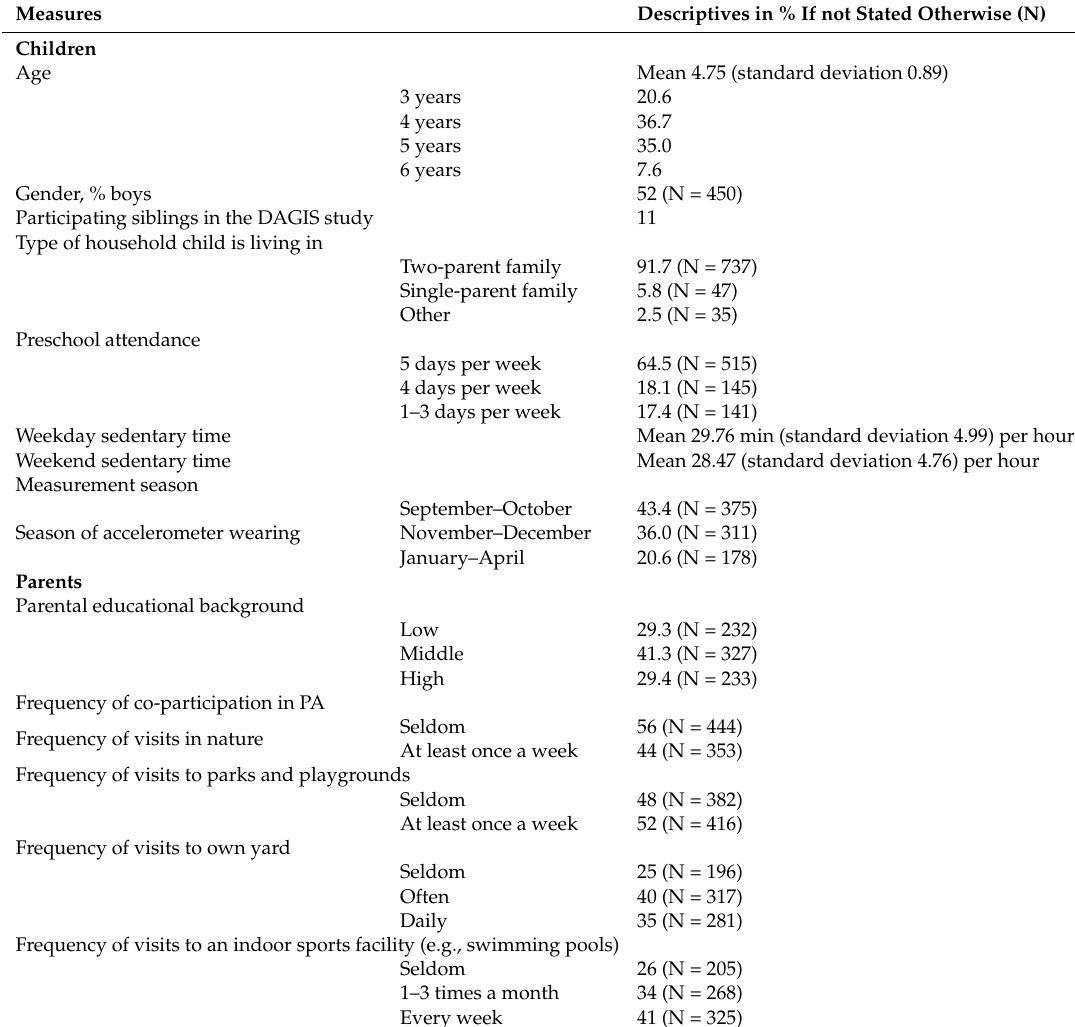
Table 1. Descriptive statistics of variables used in Increased Health and Well-being in Preschool (DAGIS)